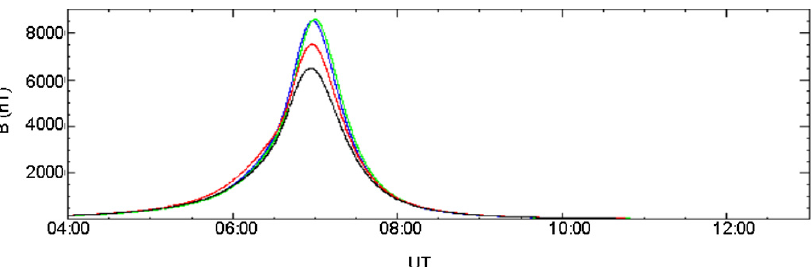
Fig. 3. Evolution of the magnetic field measured by the FGM instrument on board the four satellites. The colour code refers to the various satellites (black is C1, red is C2, green is C3 and blue is